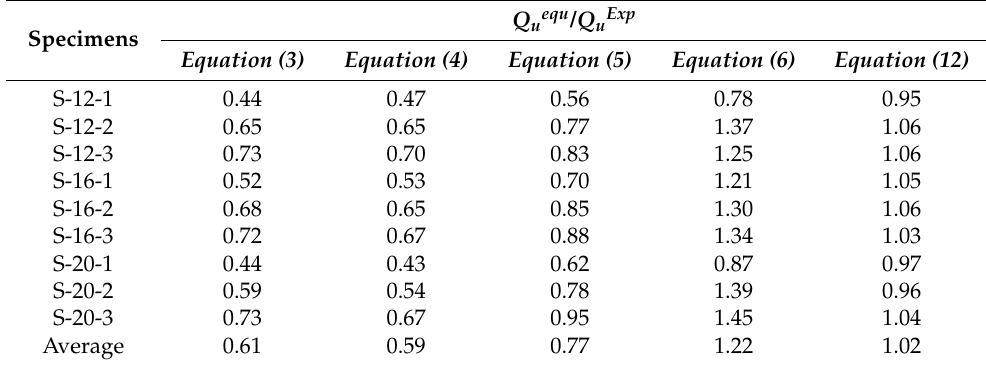
Table 5. Comparison between test and calculation